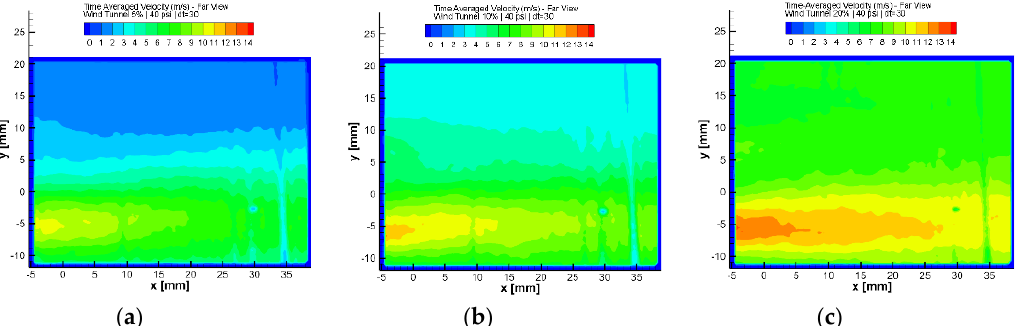
Figure 9. Instantaneous vortex-tube flow: downstream region data at 5% ( a ), 10% ( b ), and 20% ( c ) wind tunnel speeds for the 40 psi vortex condition showing the 2D version of the flow that the downstream airfoil will encounter.